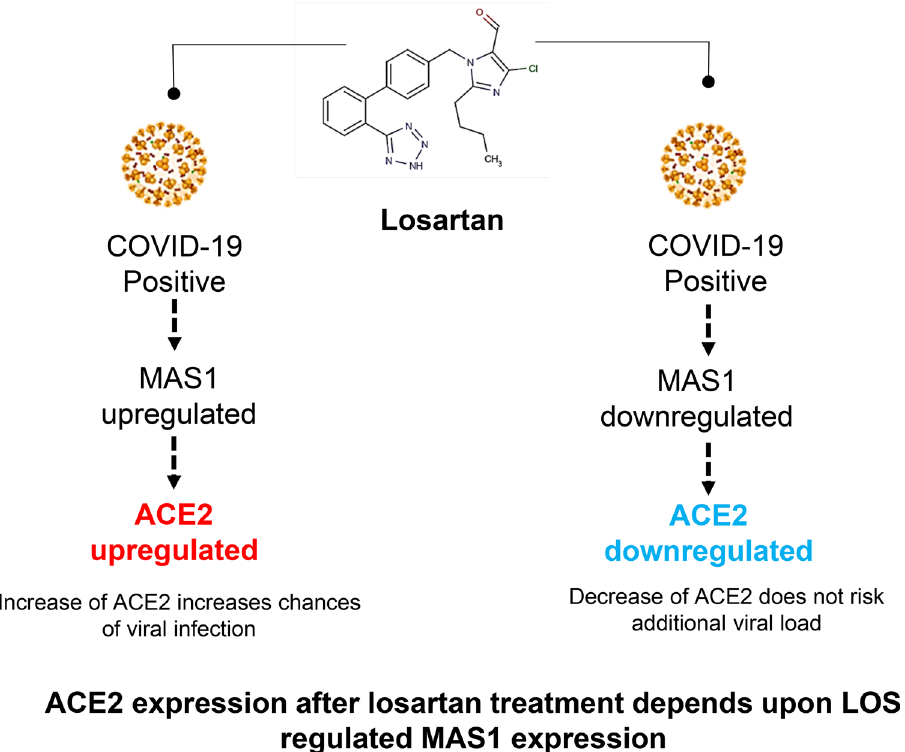
Figure 5. Schematic diagram shows controversy of losartan treatment for Covid-19. Determining the MAS1 expression could predict the response to SARS-CoV-2 viral load for patients who are already on LOS medication for pre-existing